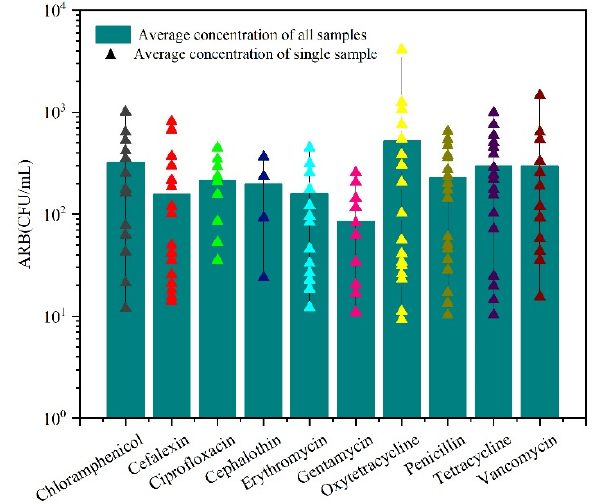
Figure 1. Ten antibiotic-resistant bacteria (ARB) were found in ballast water [92].